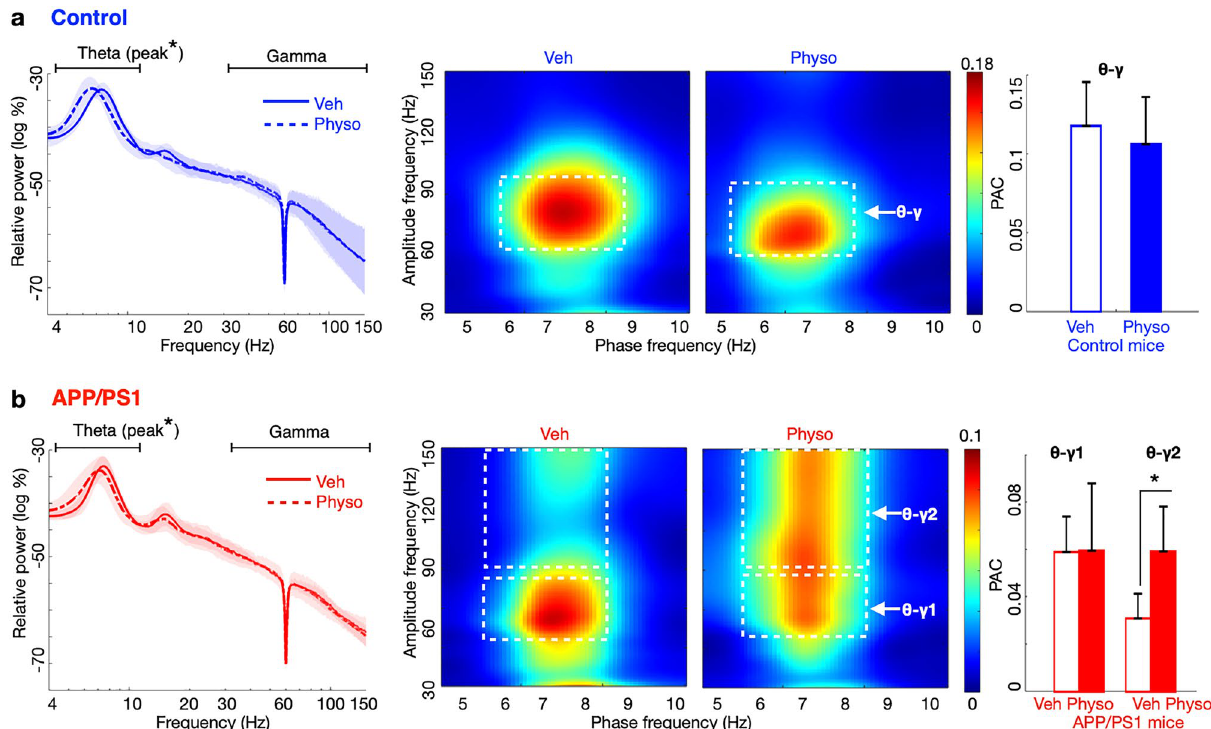
Figure 5. Acetylcholinesterase inhibitor treatment increased theta–gamma phase amplitude coupling in APP/ PS1 mice. ( a ) In control mice, physostigmine treatment decreased the frequency of the theta band peak, without affecting power in theta and gamma bands or theta (phase 6–8 Hz)-gamma (amplitude 60–90 Hz) phase amplitude coupling (PAC). ( b ) In APP/PS1 mice, physostigmine treatment decreased the frequency of the theta band peak. Physostigmine had no effect on theta (phase 6–8 Hz)-gamma PAC in the 60–90 Hz range (θ–γ1) and selectively increased theta (phase 6–8 Hz)-gamma PAC in the 90–150 Hz range (θ–γ2). White dashed squares: regions of quantified PAC; * p < 0.05; paired t-tests. Control n = 7, APP/PS1 n = 7 mice. Data in ( a ) left and ( b ) left are smoothed with a Gaussian window (σ = 2 Hz) for display. Data are represented as mean ±